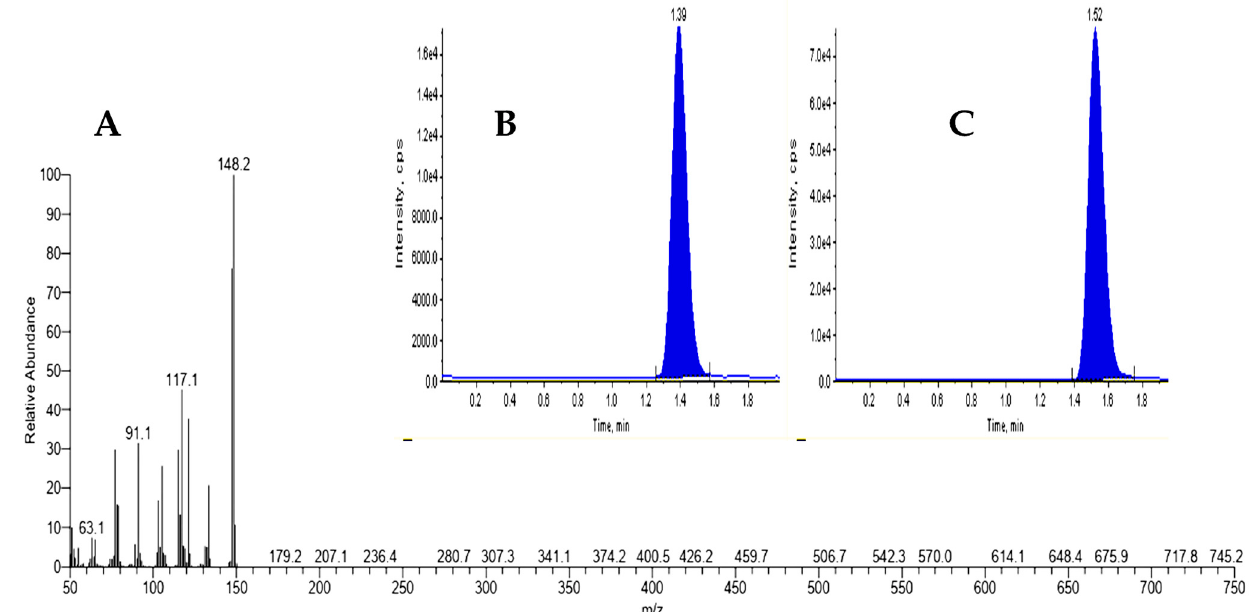
Figure 6. Quantitative analysis of estragole in aniseed. ( A ) Aniseed fragment ions for estragole standard. ( B ) Estragole peak retention time was revealed at 1.39. ( C ) p -anisaldehyde internal standard peak retention time was observed at